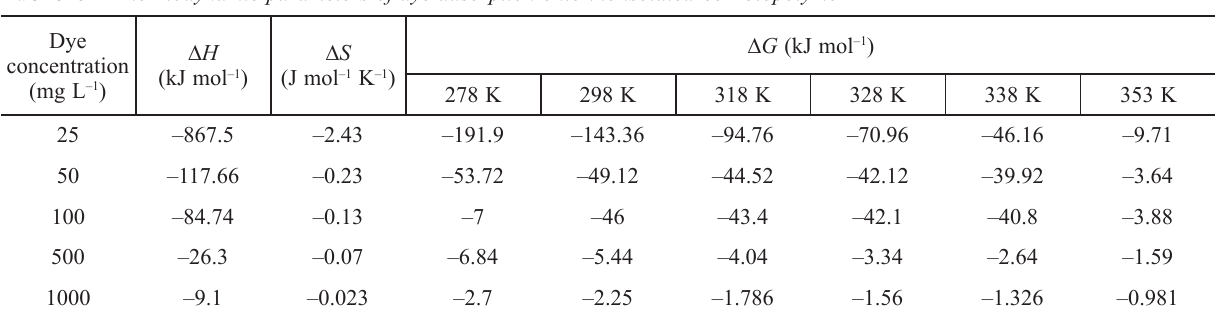
Table 5 – Thermodynamic parameters of dye adsorption onto the isolated 40B biopolymer Dye concentration